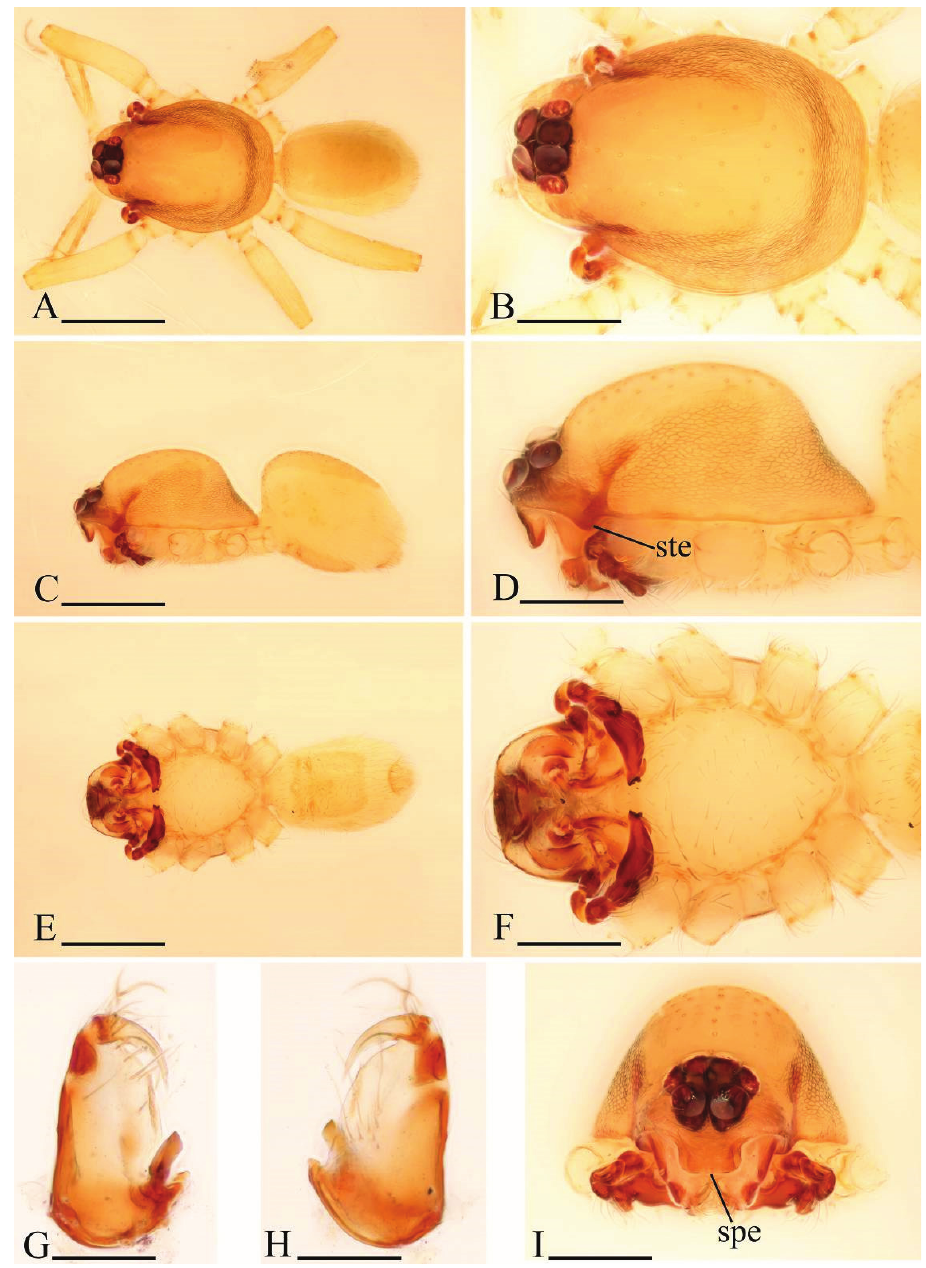
Figure 13. Ischnothyreus tectorius sp. n., male. A, C, E habitus, dorsal, lateral and ventral views B, D, F, I pro- soma, dorsal, lateral, ventral and anterior views G, H left chelicera, anterior and posterior views. Abbreviations: spe = strongly protruding extension; ste = sclerotized, triangular extension. Scale bars: A, C, E = 0.4 mm; B, D, F, I = 0.2 mm; G, H = 0.1